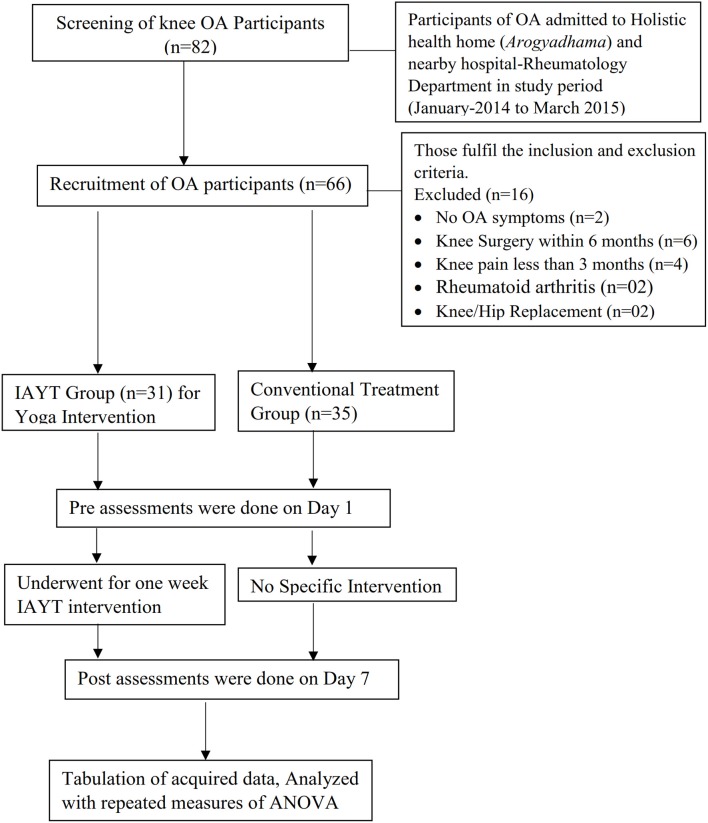
CONSORT Flow diagram of study participants.